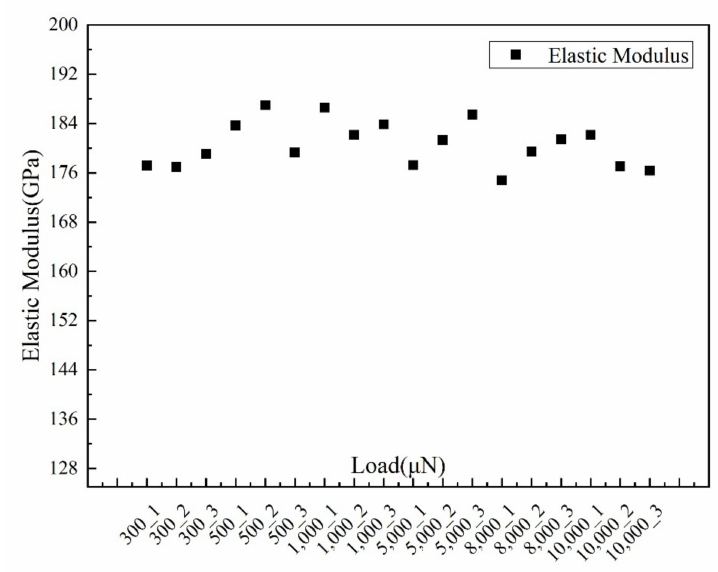
Figure 8. Elastic modulus of LN under different